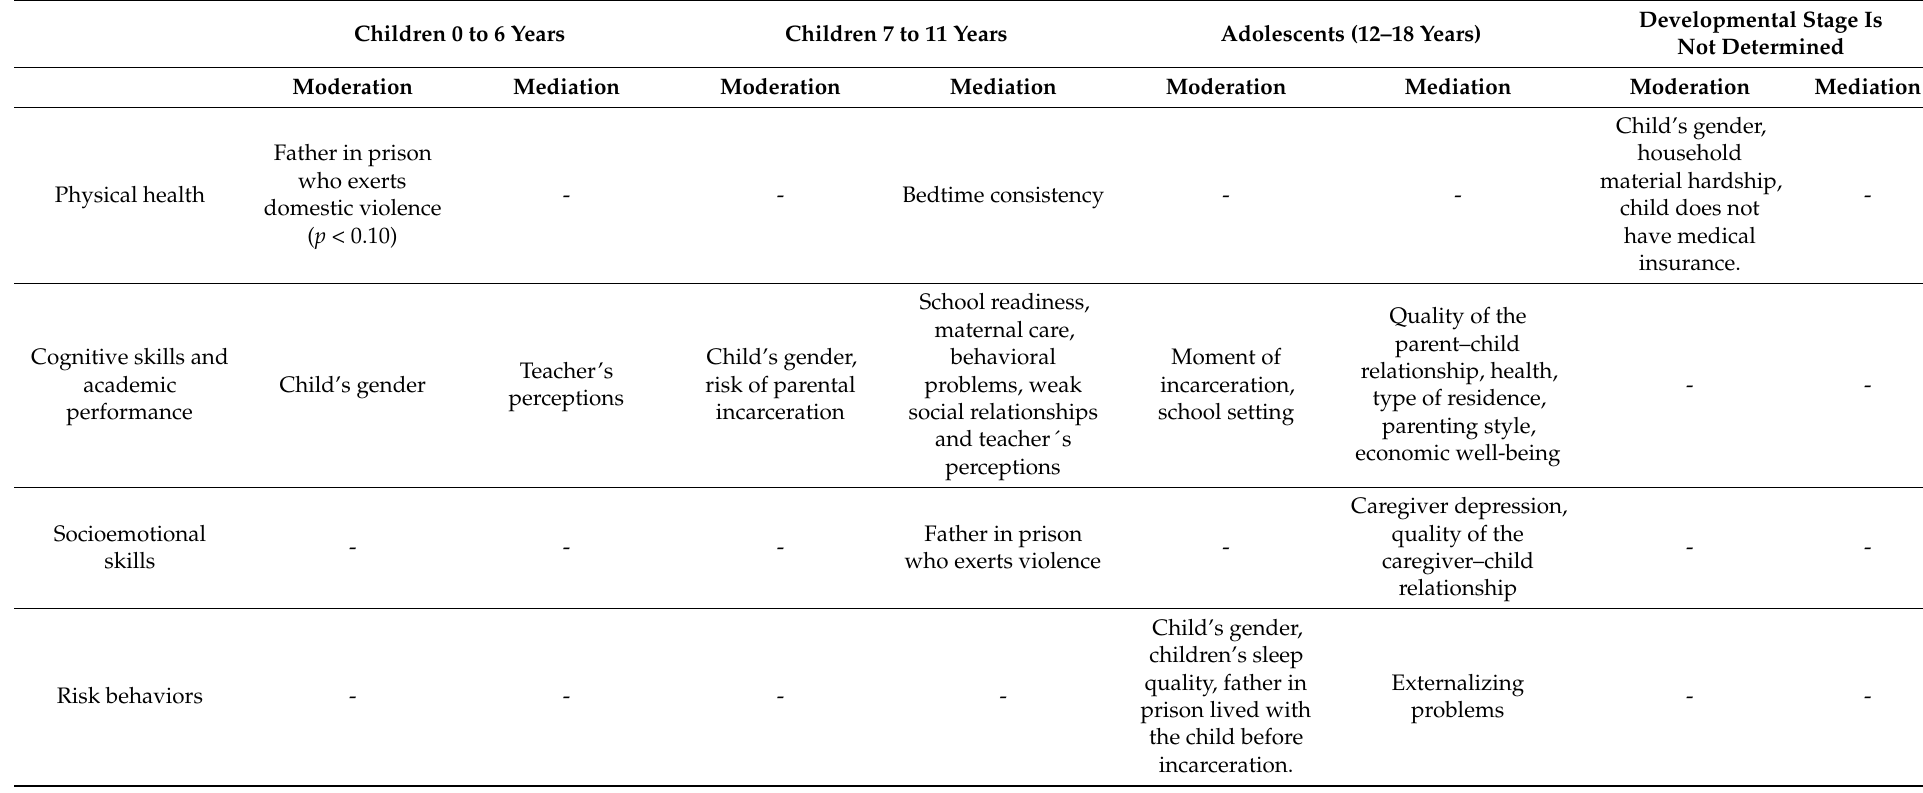
Table 2. Summary of moderators and mediators in the relationship between parental incarceration and different